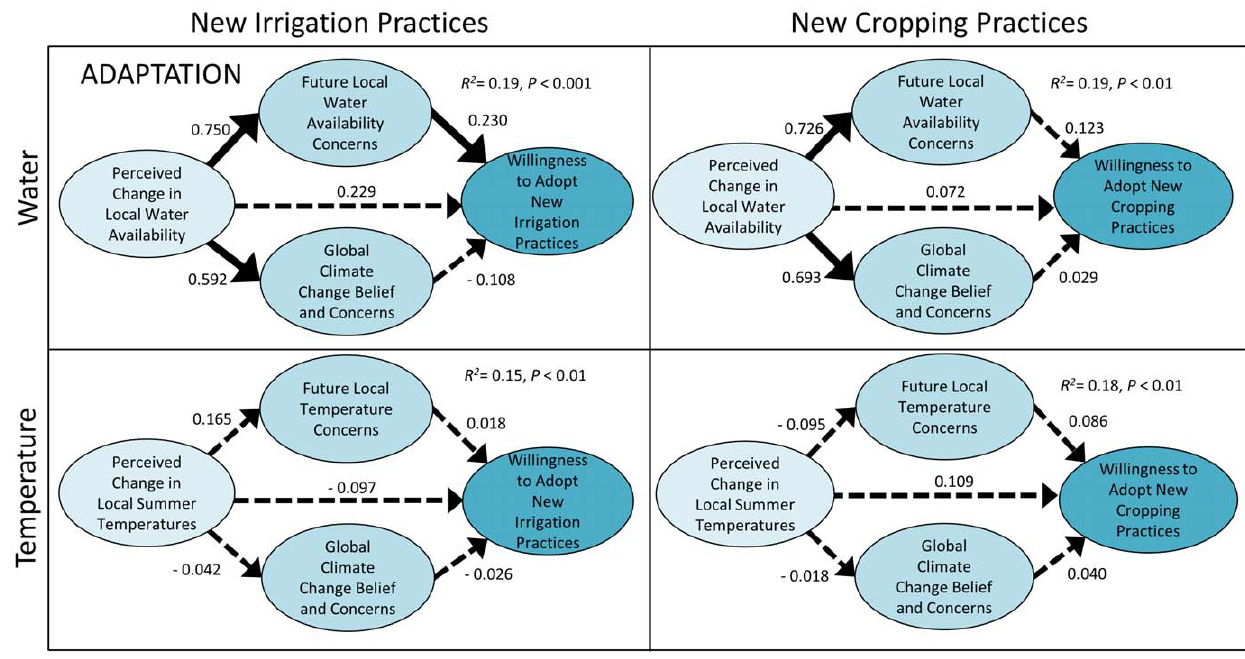
Figure 3. Multiple-mediation models examining the direct and indirect effects of perceived change in local climate (water, temperature) on farmers’ willingness to adopt climate change adaptation practices. Values provided are unstandardized b coefficients indicating the strength of the relationship between variables. Solid arrows represent a significant effect between variables in the pathway (P , 0.05), while broken arrows indicate no significant effect. Overall R 2 and P values associated with prediction of dependent variables are listed for each model.